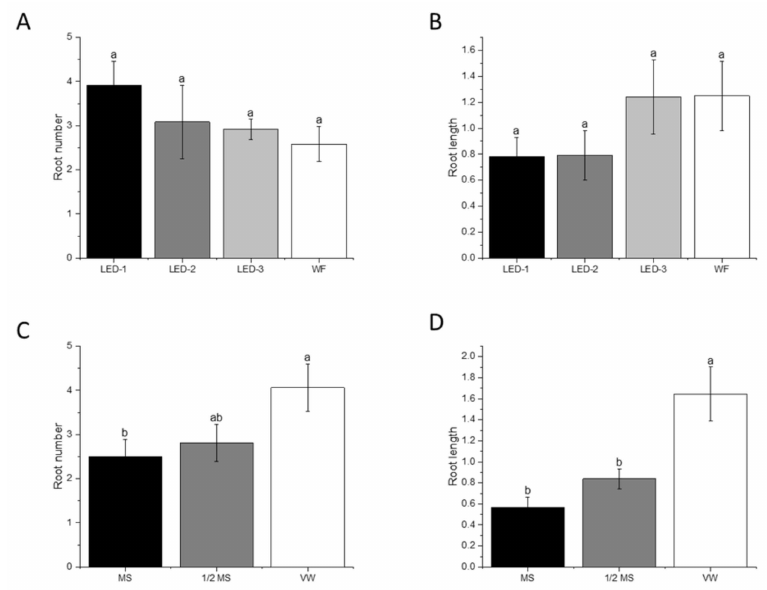
Figure 4. Effects of light sources and culture media on root number ( A , C ) and root length (cm) ( B , D ) on B. nodosa in vitro plantlets after 60 days of culture establishment. LED-1: Light-emitting diode (LED) light with 1575 ± 50 µ mol m − 2 s − 1 Photosynthetic Photon Flux Density (PPFD); LED-2: LED light with 1015 ± 50 µ mol m − 2 s − 1 PPFD; LED-3: LED light with 80 ± 5 µ mol m − 2 s − 1 PPFD; and WF: white fluorescent with 50 ± 5 µ mol m − 2 s − 1 PPFD. MS: MS basal medium supplemented with 30 g L − 1 sucrose and 7 g L − 1 agar; 1 / 2 MS: half-strength MS basal medium supplemented with 15 g L − 1 sucrose and 7 g L − 1 ; VW: VW basal medium supplemented with 10% coconut water, 20 g L − 1 sucrose and 7 g L − 1 . Bars indicate mean ± SE. Different letters indicate significant